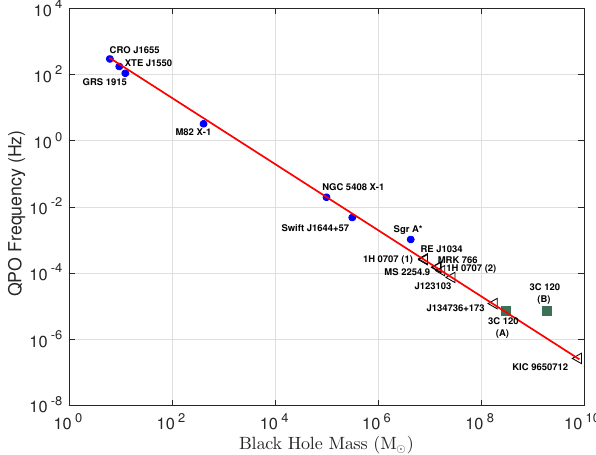
Figure 5. Updated version of Figure 1 from [22] describing relationship between QPO frequency and BH mass. The solid line represents the model f(Hz) = 1862(M BH /M (cid:12) ) given by [26]. Non-AGN sources are displayed with blue circles, and AGN sources with significant QPOs are shown with black triangles. Two significant QPOs for 1H 0707–495 [55] are displayed as (1) and (2). The position of 3C 120 in this diagram is shown as filled green square (A) with BH mass estimated assuming a Kerr BH, and (B) with BH mass estimated assuming a Schwarzschild